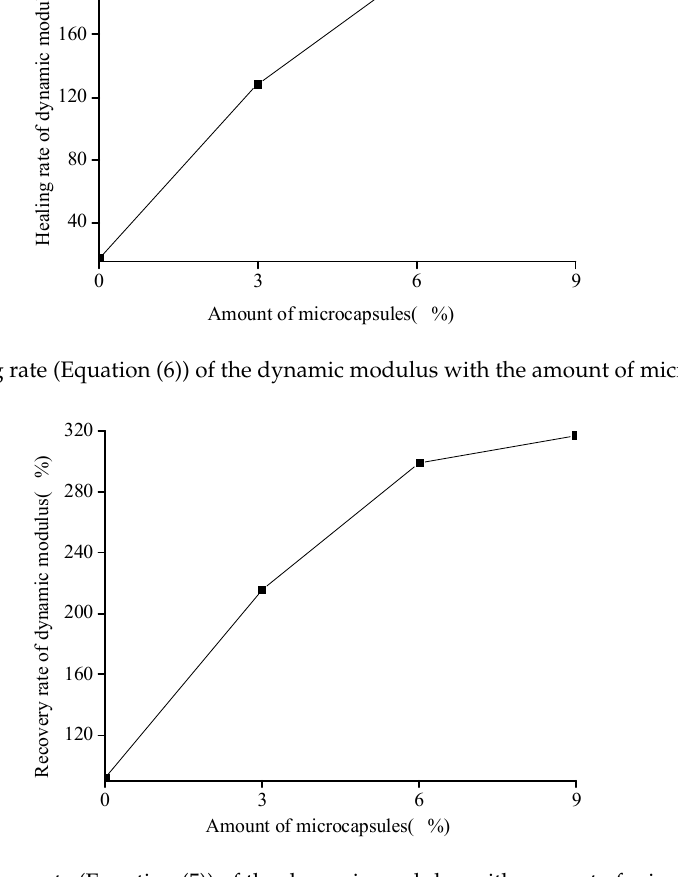
Figure 9. Recovery rate (Equation (5)) of the dynamic modulus with amount of microcapsules.